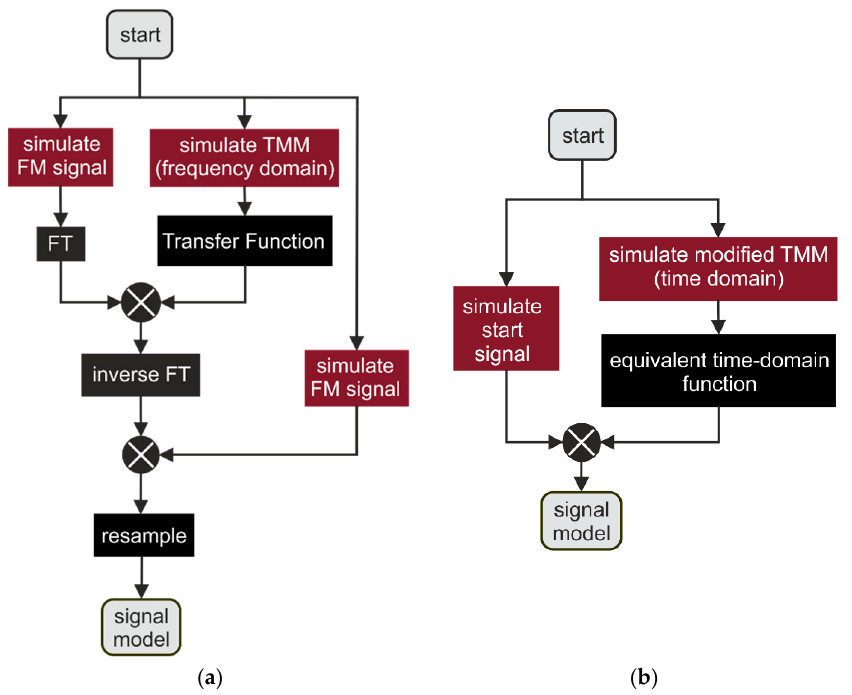
Figure 5. ( a ) Block diagram of the classical transfer matrix method (TMM) calculation. ( b ) Block diagram of the modified TMM calculation. FT, Fourier transformation.